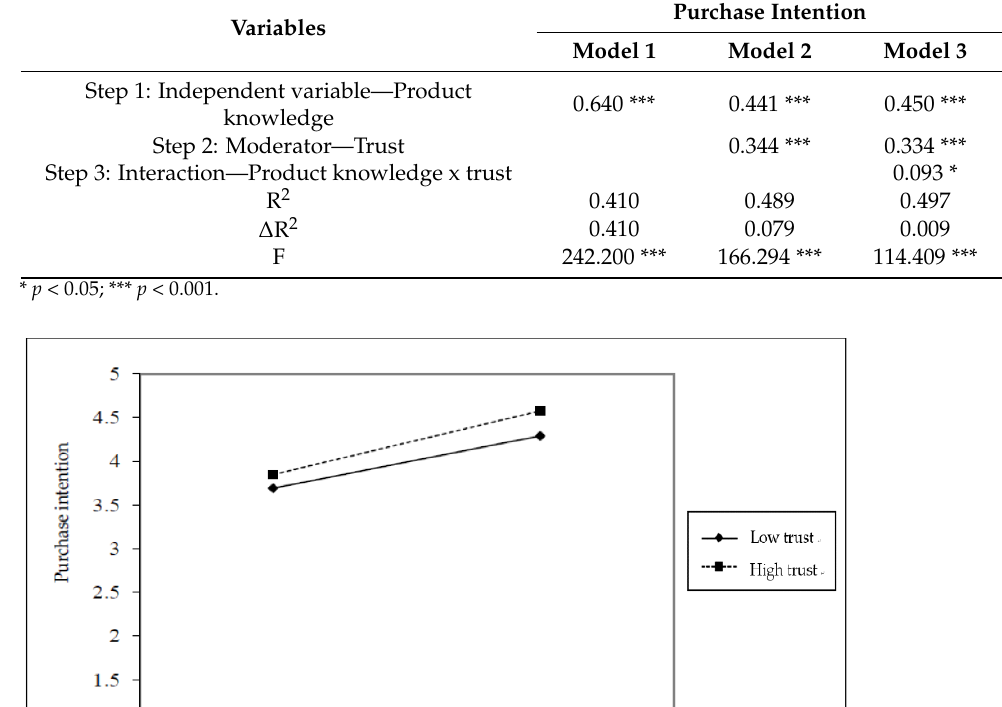
Table 5. Results of hierarchical regression analysis.